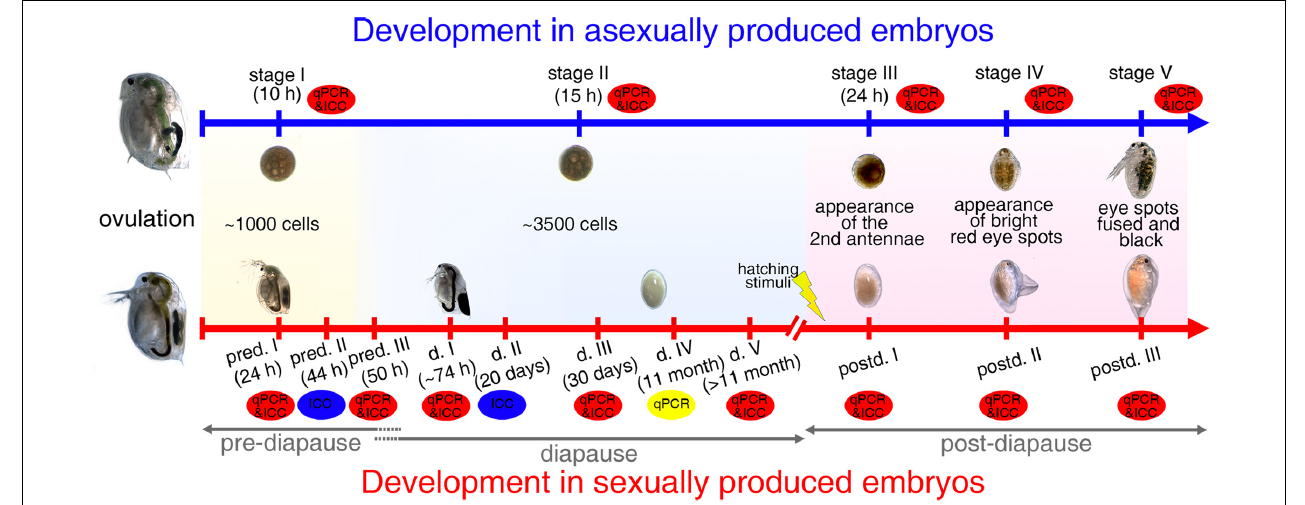
FIGURE 1 | Embryogenesis in D. magna asexually and sexually produced embryos. Representative and comparative sampling stages collected for qPCR and immunolabeling experiments: “stage I” asexually produced embryos and “pred. I” sexually produced embryos contain ∼ 1,000 cells; “pred. II” embryos are collected 44-h post-ovulation; “stage II,” “pred. III,” and “d. I/II/III/IV/V” embryos contain ∼ 3,500 cells; “stage III” and “postd. I” embryos are collected when second antennae are formed; “stage IV” and “postd. II” embryos have two bright red-eye spots; “stage V” and “postd. III” embryos are determined based on formation of one black compound eye. pred.: pre-diapause; d.: diapause; postd.: